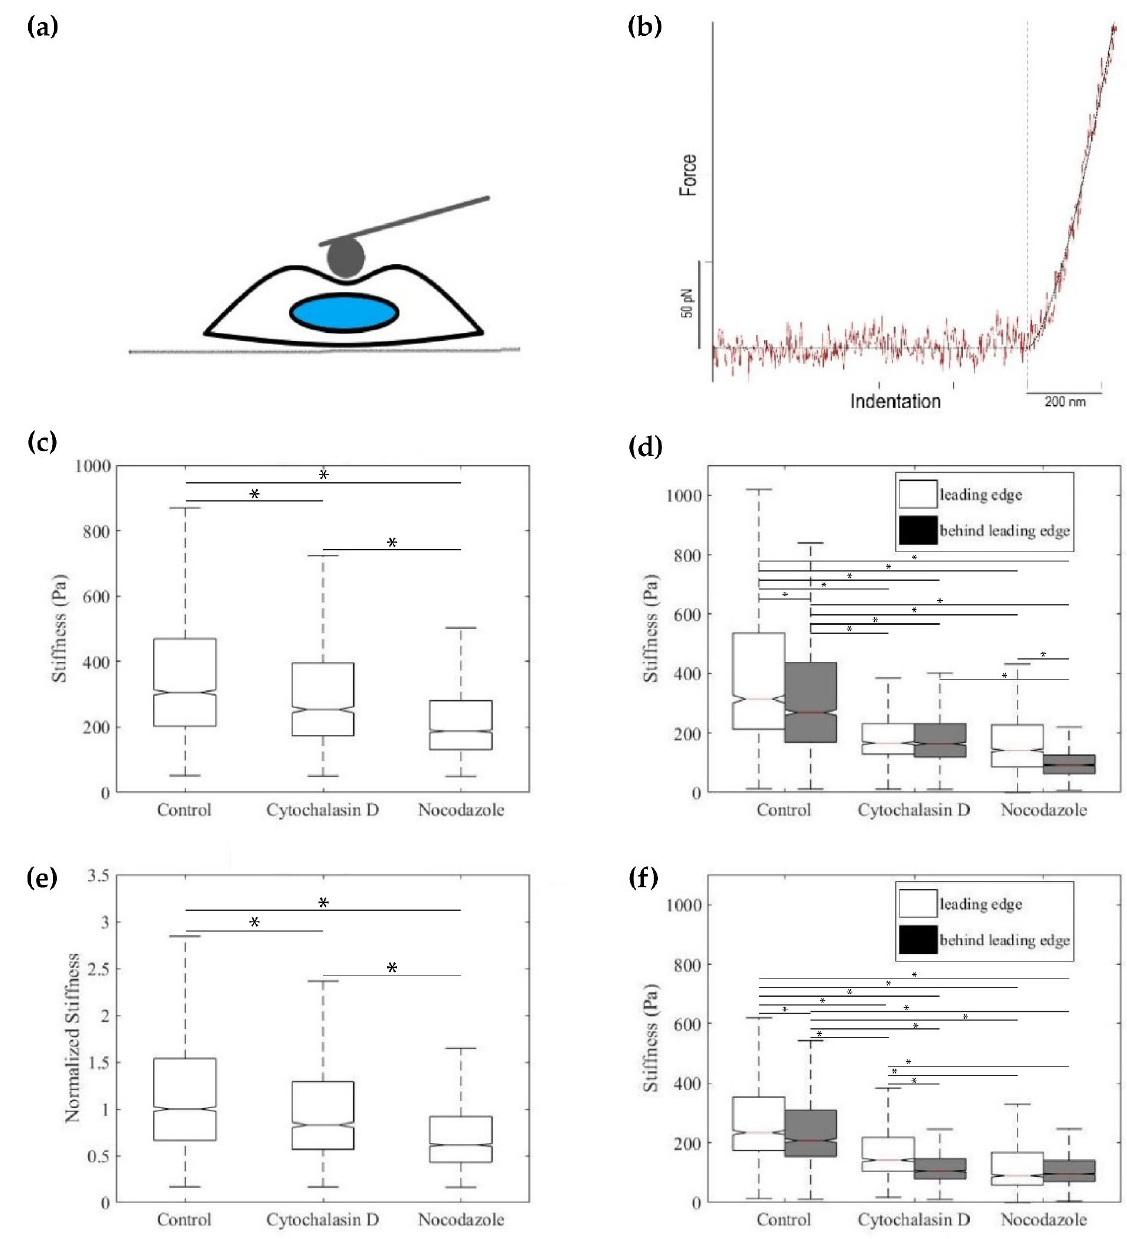
Figure 7. ( a ) Schematic of live cell indentation via AFM. ( b ) Force curve obtained over the duration of indentation. ( c – f ) The middle bar represents the median value of the distribution, and the notch represents the 95% confidence interval. ( c ) Compressive Modulus of ECs under varying cytoskeletal disruptions. ( d ) Measured compressive moduli of HUVECs 1 h after wound. ( e ) Compressive moduli of cytoskeletal disruptions normalized to the compressive modulus of the control. ( f ) Measured Compressive moduli 16 h after wound (* p < 0.05).